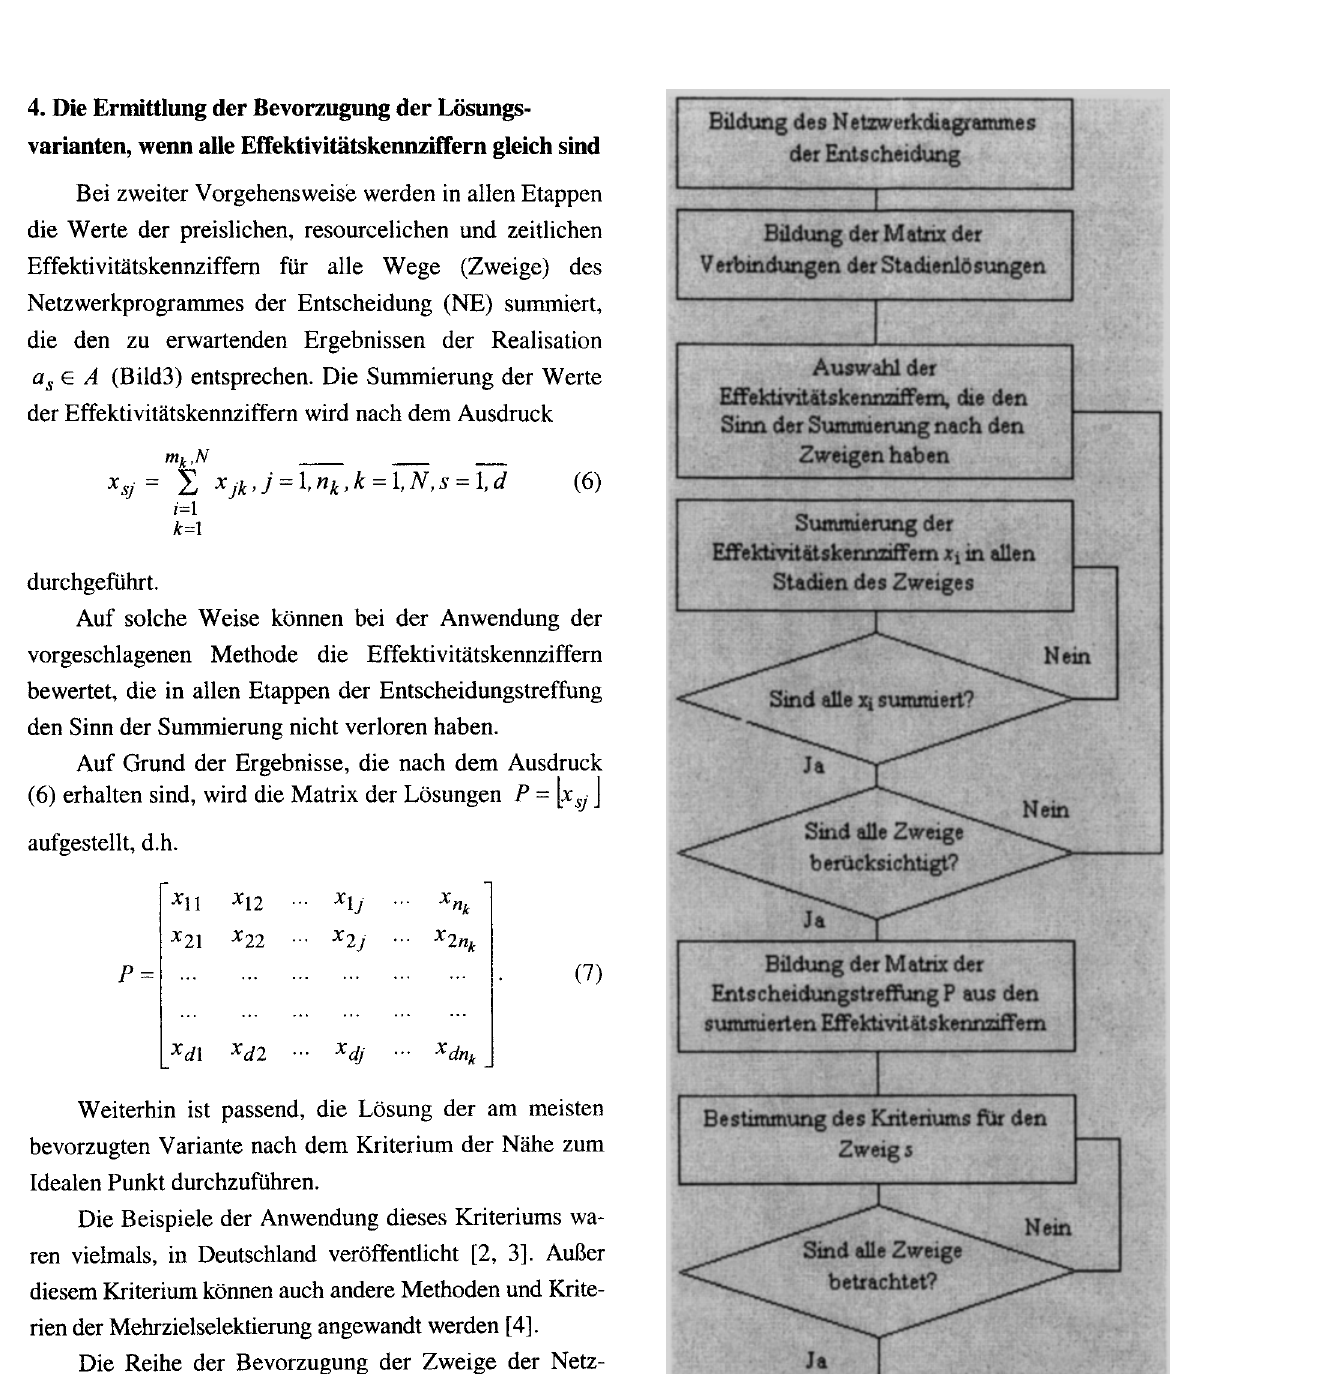
Fig 3. Scheme of algorithm C3 for technical and organisational - technological solutions synthesis